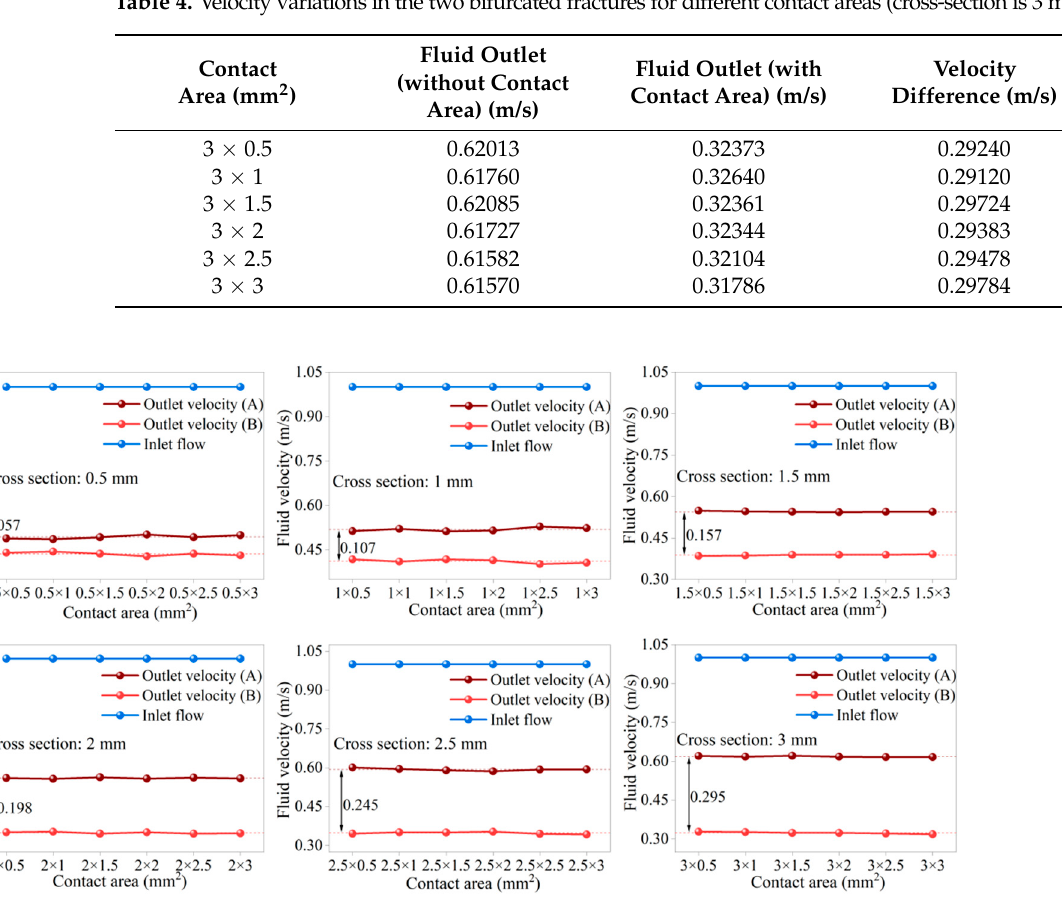
Figure 8. Velocity variations in the bifurcated fracture B for a constant cross-section of 3 mm (veloc- ity: m/s). ( a – f ): Velocity variations in the bifurcated fracture B for a constant cross-section of 3 mm with different contact areas.